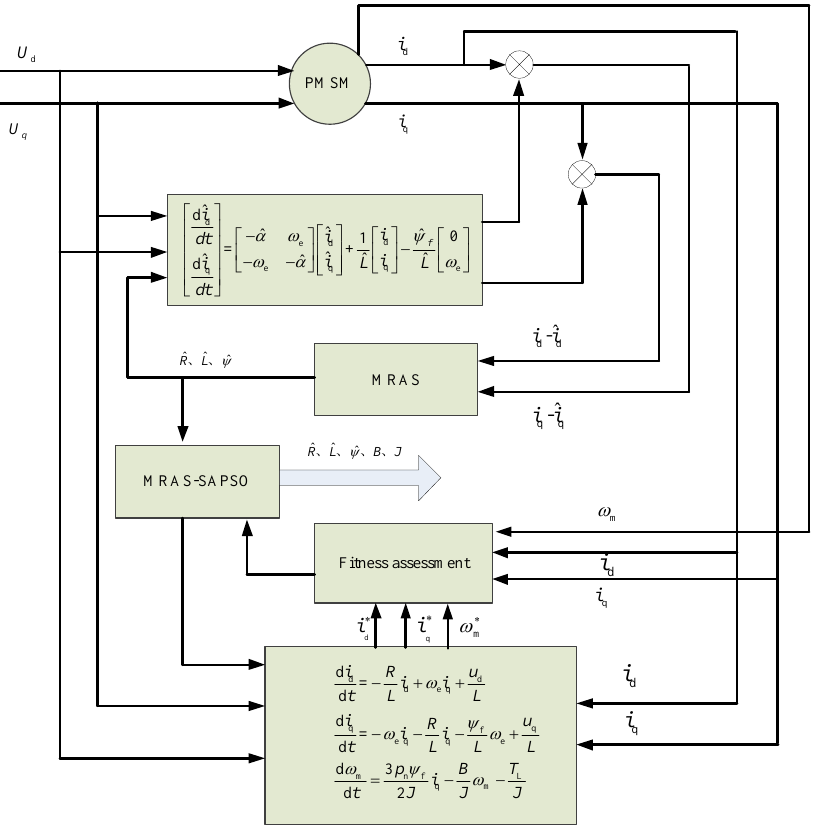
Figure 2. Principle of PMSM multiparameter identification based on MRAS-SAPSO.